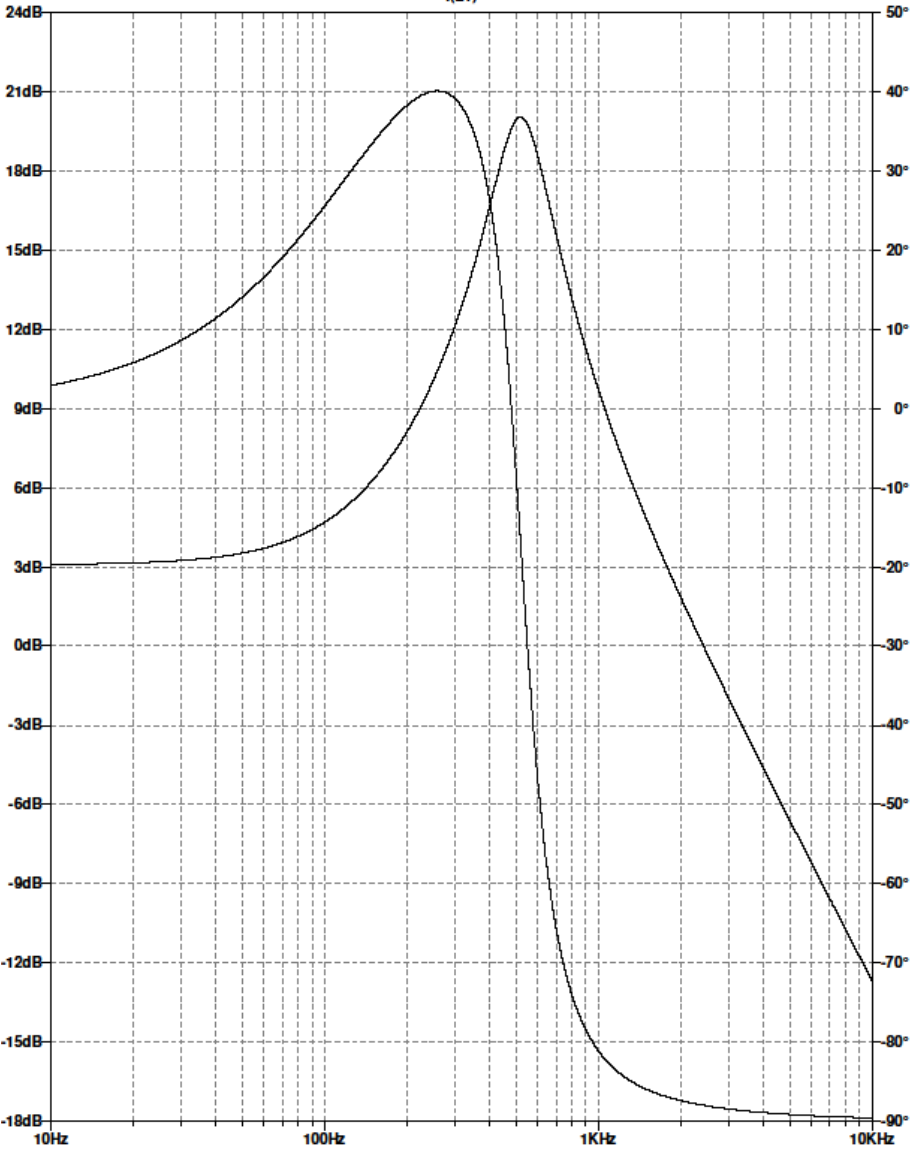
Figure 16. Frequency response of G id for the practical synchronous buck converter using LTspice.